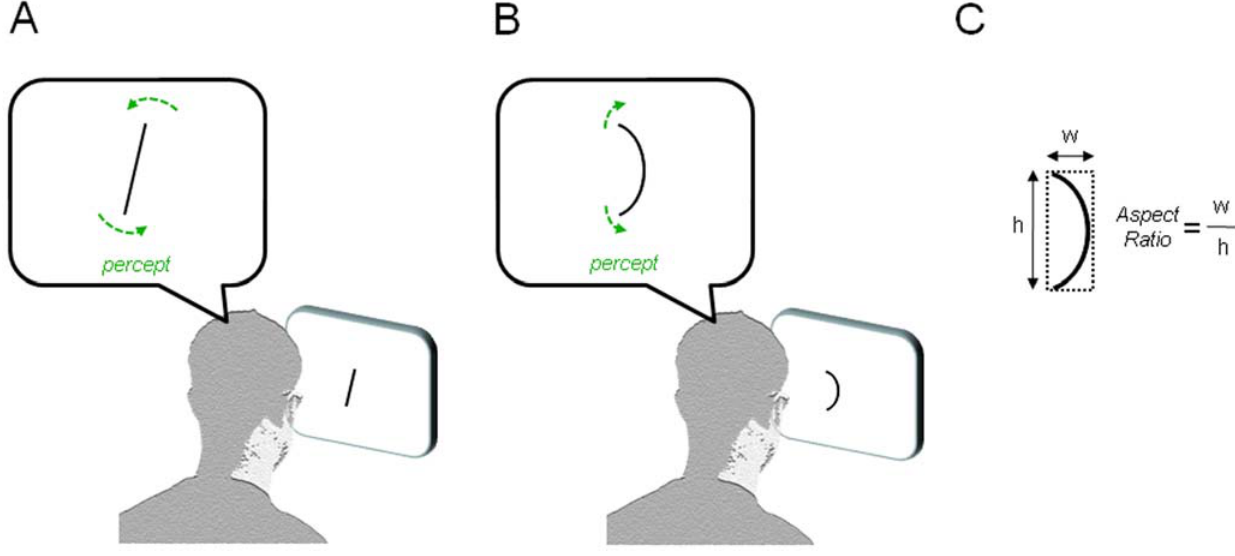
Figure 1. Perceptual drift during prolonged adaptation to simple, unchanging visual stimuli. A. During inspection of a line tilted slightly from vertical, the line will appear to drift toward the vertical orientation. B. During inspection of a curved line, the line will appear to straighten. C. The shape of the curves is determined through a single parameter, the unit-less aspect ratio (width/height). Stimuli are shown as black on a white background, though in the actual experiments the stimuli were white on a black